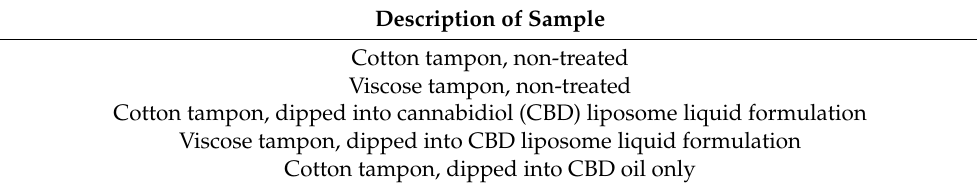
Table 1. List of tampon samples and description of functionalized procedure used. Description of